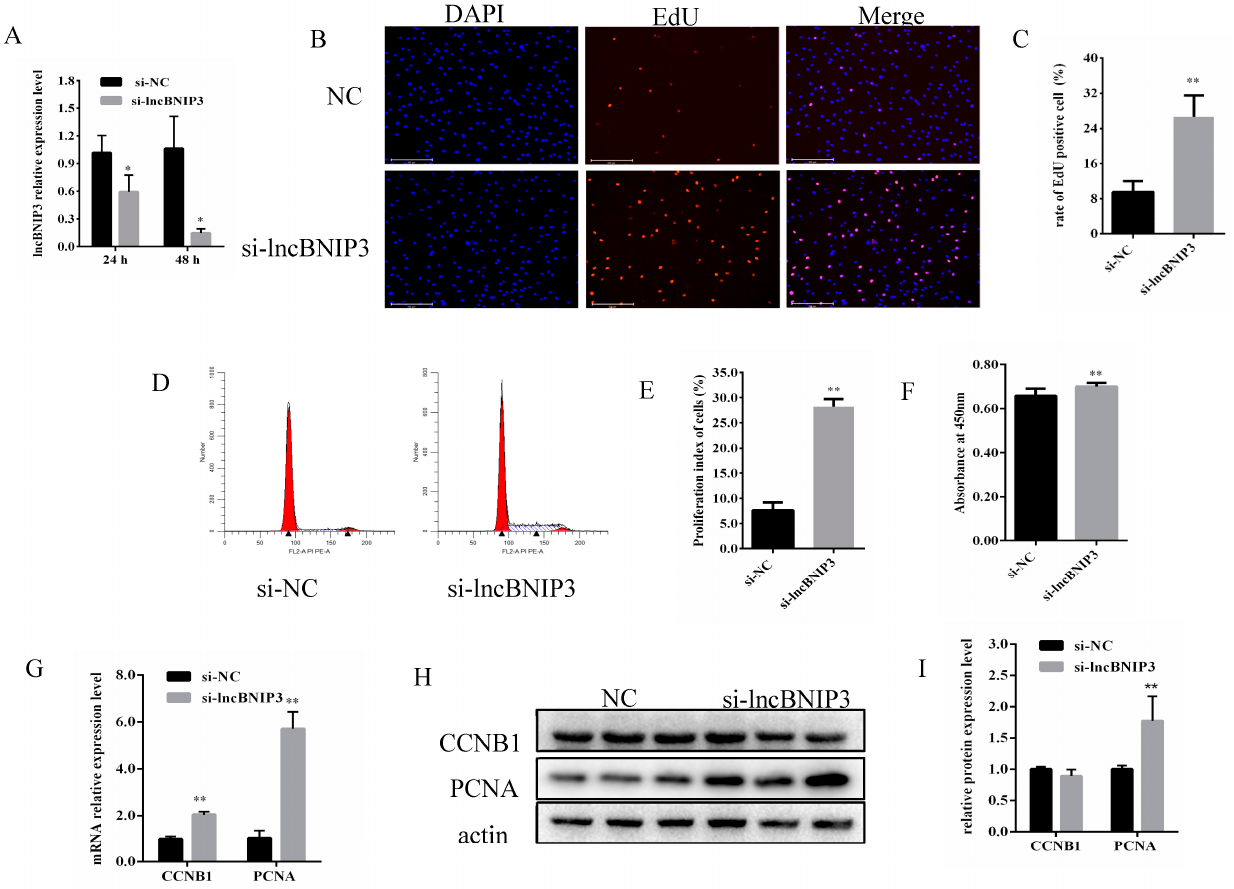
Figure 2. Interference with lncBNIP3 promoted the proliferation of bovine intramuscular preadipocytes. ( A ) Interference efficiency of si-lncBNIP3 for 24 h and 48 h; ( B ) EdU staining results (200×),